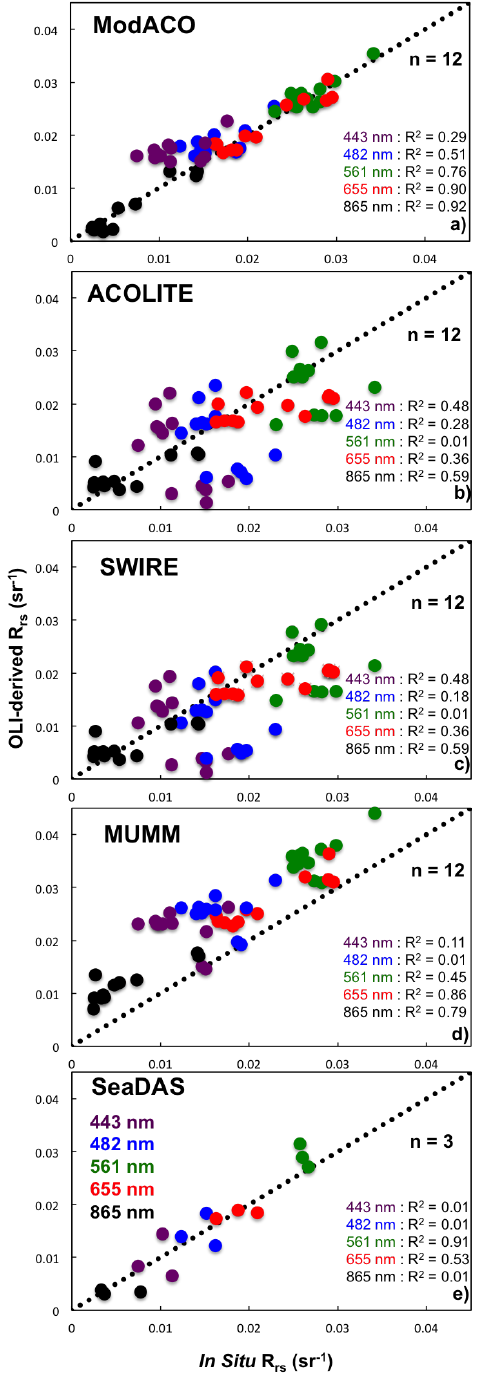
Figure 2. Correlation plots of in situ and OLI-derived R rs values using different atmospheric correction schemes. The SeaDAS standard processing only yield valid R rs values on April 20, 2017 image. The dotted line pertains to the 1:1 correspondence.